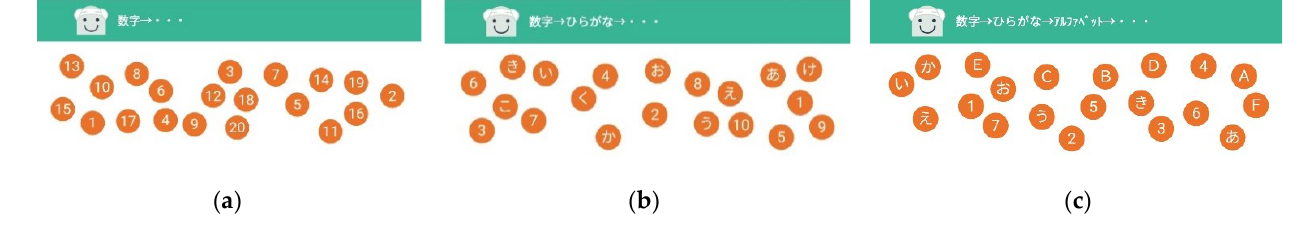
Figure 1. Measurement protocol.